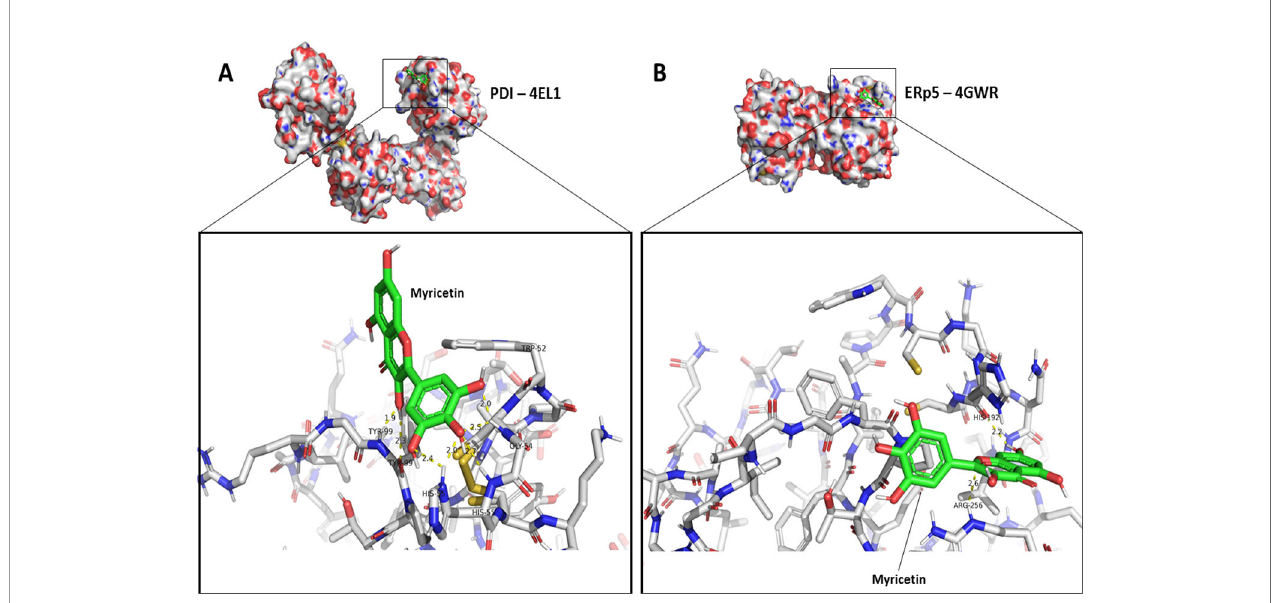
FIGURE 7 | Feasible interactions for Myricetin with PDI and ERp5 predicted through molecular docking. The predicted poses of interaction between myricetin and different thiol isomerases were assessed using AutoDock 4.2 package as described in Methods. (A) Pose of highest af fi nity for PDI and detailed intermolecular interactions. (B) Pose of highest af fi nity for ERp5 and detailed intermolecular interactions. Additional information on interactions and other possible poses are described in Supplementary Tables 1 and 2